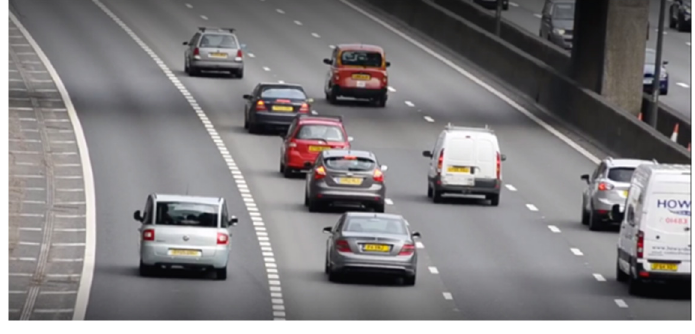
Figure 2. Visual stimuli for the traffic (stressor) condition.